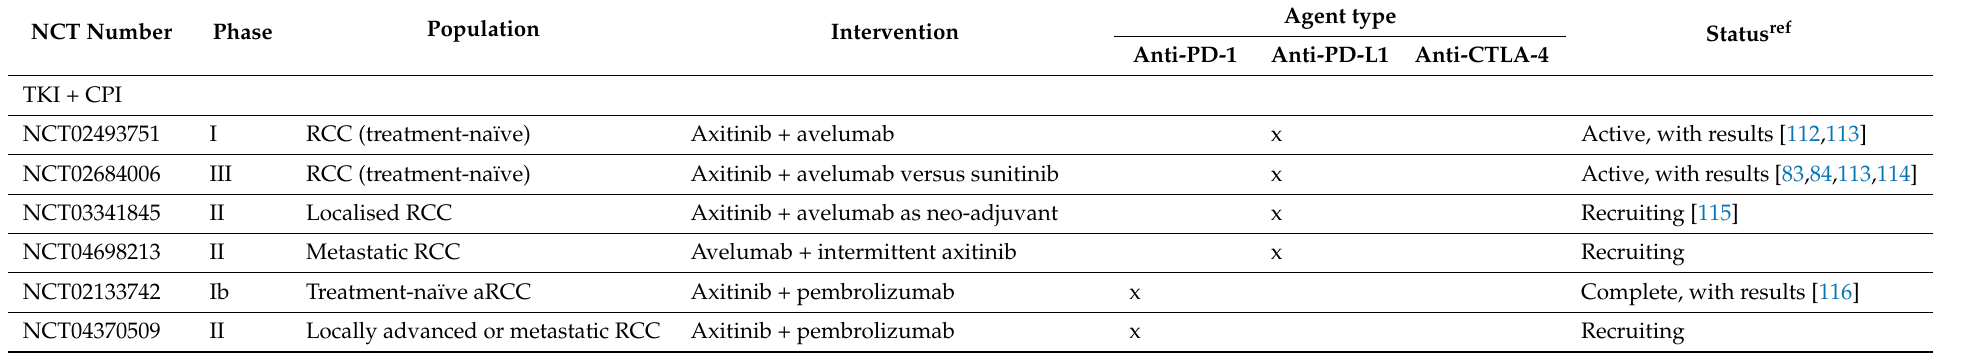
Table 3. Ongoing clinical trials of combination CPI/anti-VEGF-targeted therapy (TKI or mAb) in